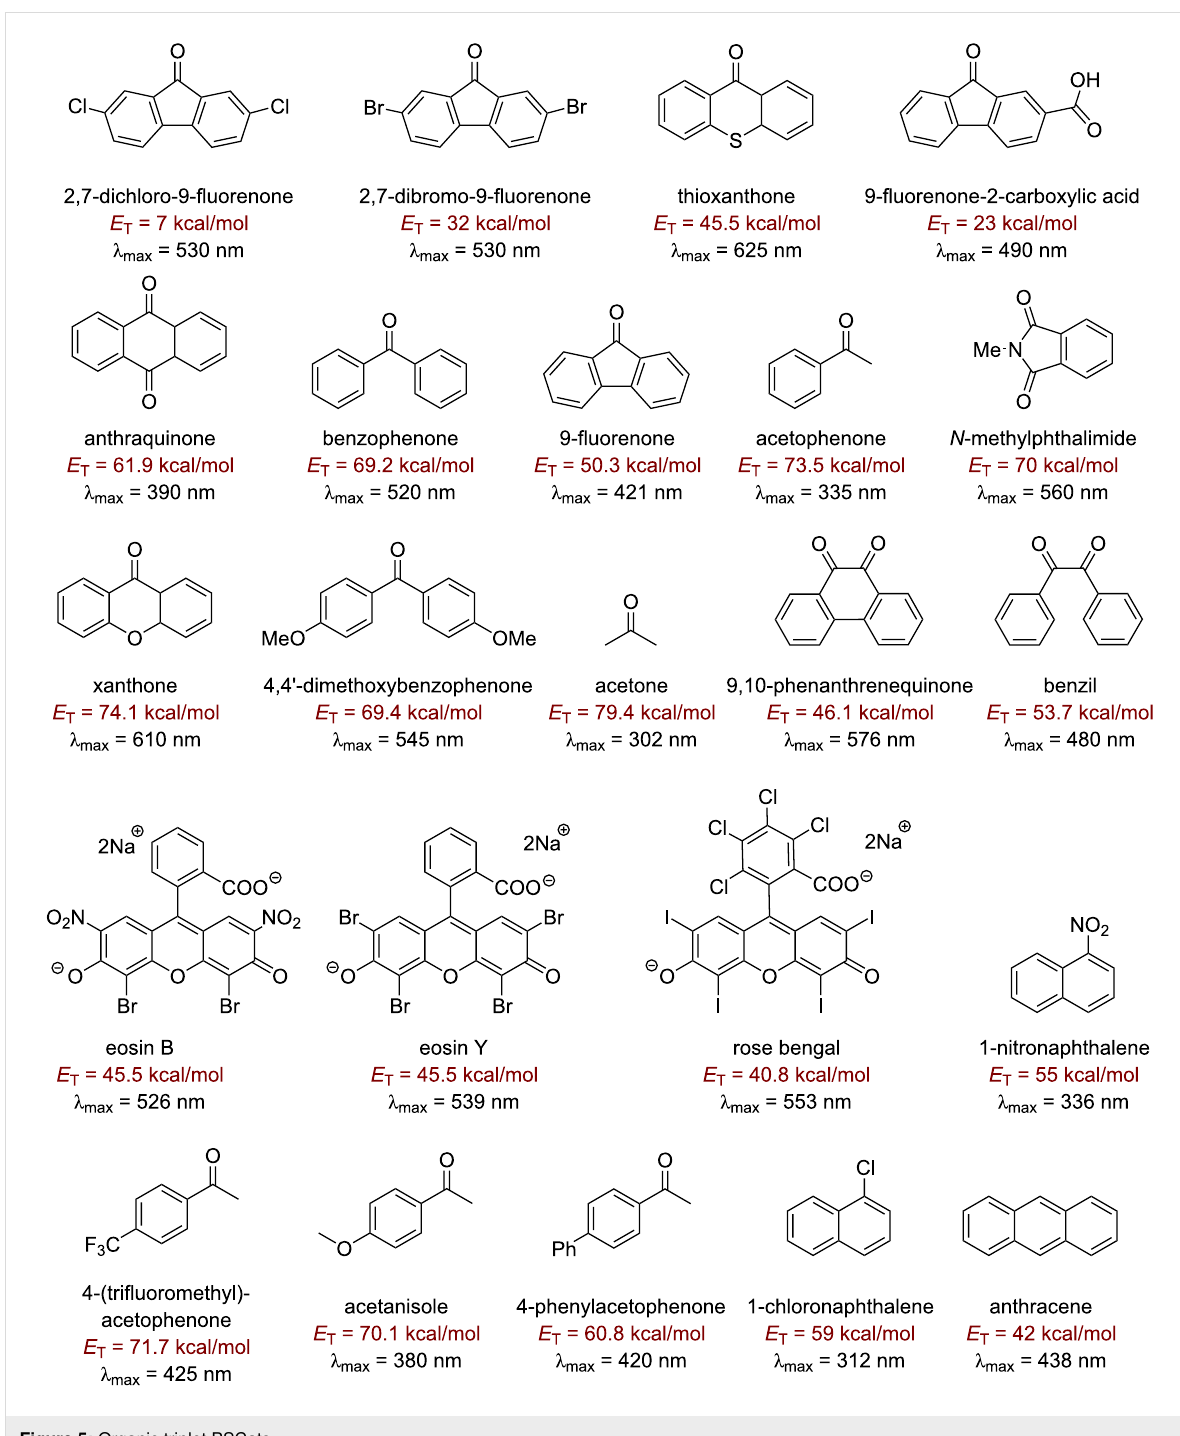
Figure 5: Organic triplet PSCats.